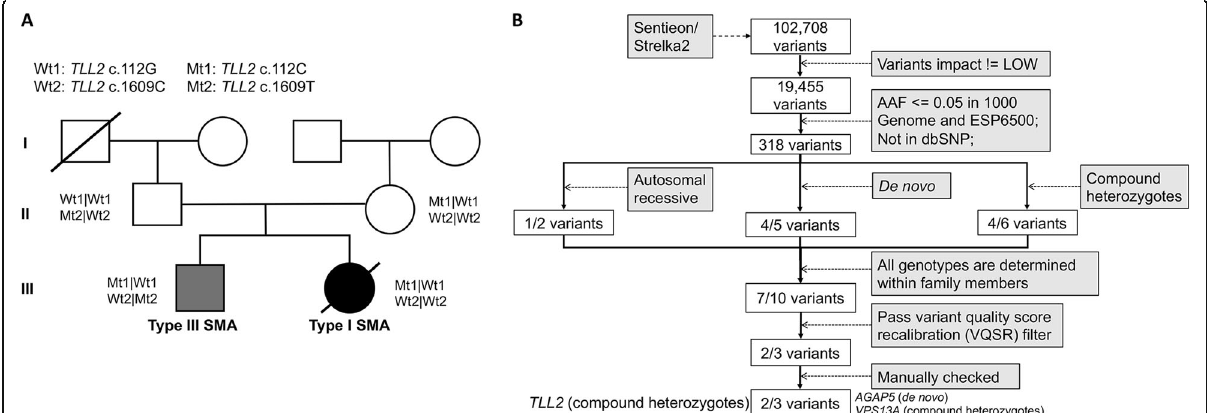
Fig. 3 Pedigree and WES analysis strategy of SMA-discordant family. a The pedigree of the family. The man (layer II) married a woman (layer II) who came from the same village and they had two SMA affected children. The male (layer III) was diagnosed with type III SMA (gray) and the female was diagnosed with type I SMA (black). The female patient died at the age of 11. The parents and the two patients were sequenced by WES. And compound heterozygous mutations in TLL2 were identified on the male patient ’ s genome. b Variants filtering pipeline of the analysis. Sentieon (https://www.sentieon.com) and Strelka2 (https://github.com/Illumina/strelka) were used to call the variants of the four samples. And the variants that called by both tools were kept for the further analysis. The variants were analyzed with GEMINI (https://github.com/arq5x/gemini). N/ M represents that N variants were identified on the male patient ’ s genome and M variants were identified on the female patient ’ s